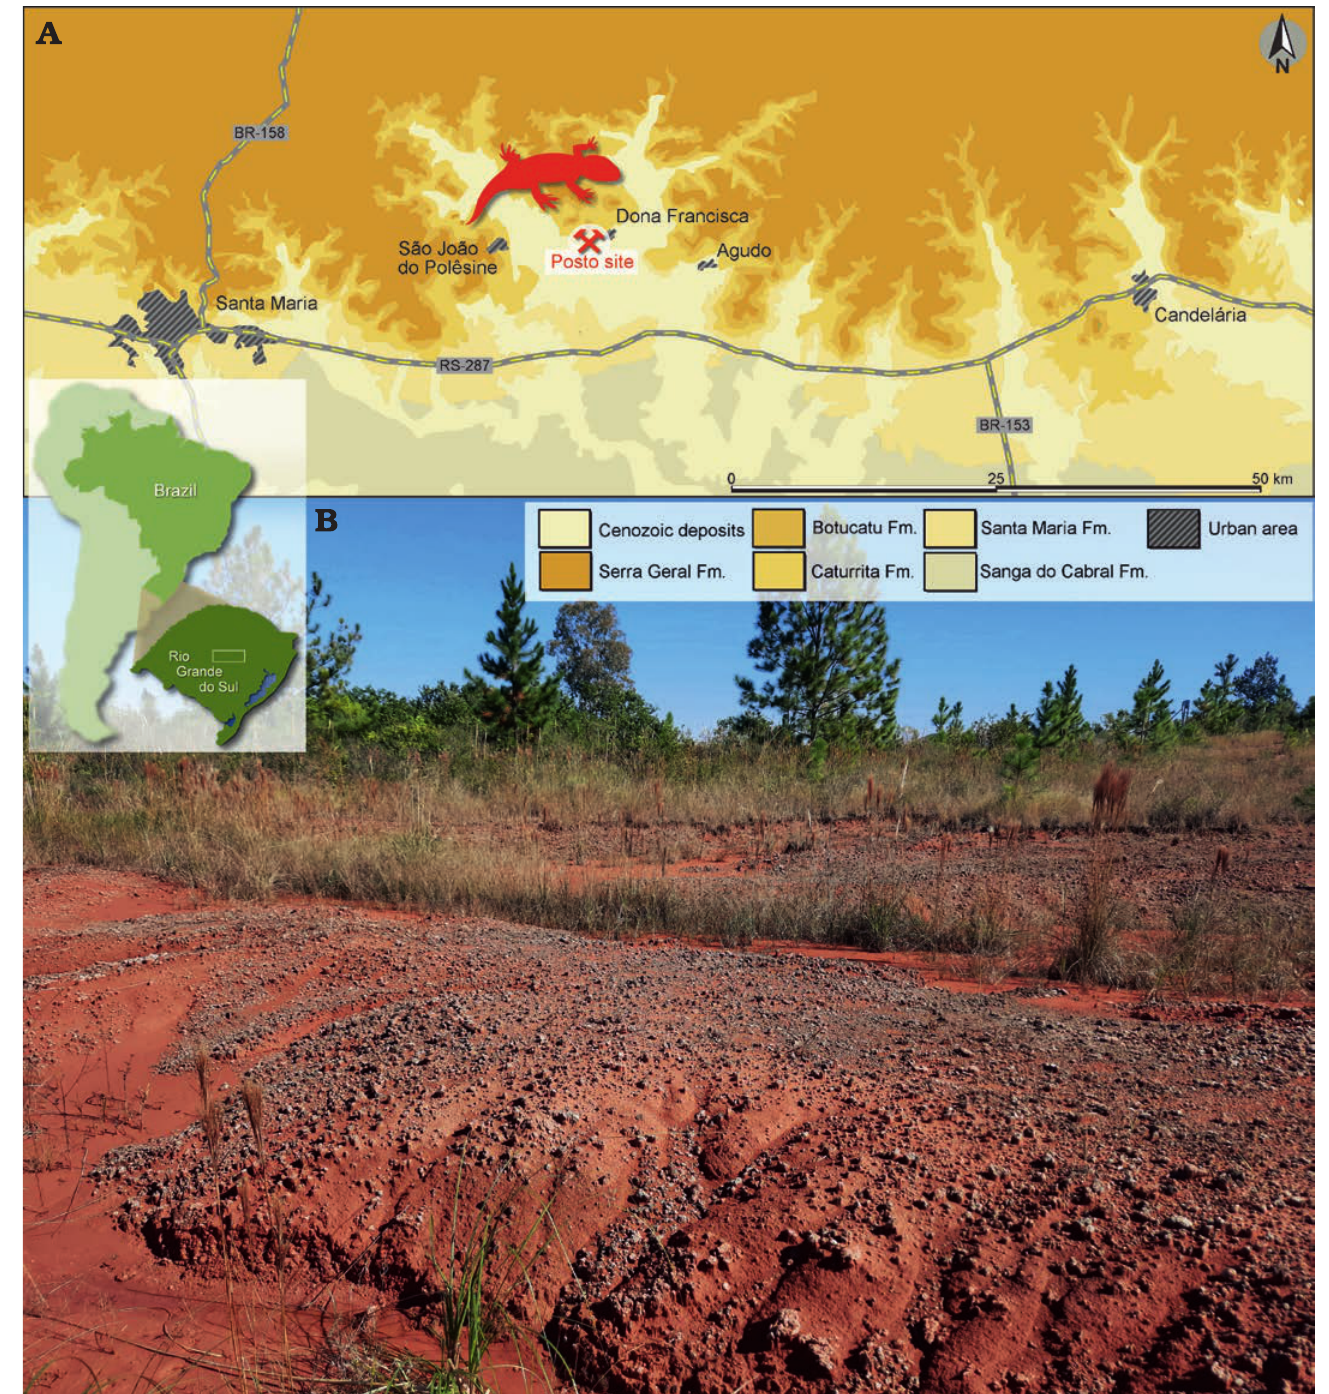
Fig. 1. A . Map of the “Posto” site and the surface distribution of the geologic units in the area (modified from Müller et al. 2020). Location of the study area within South America (inset). B . General view of the “Posto”